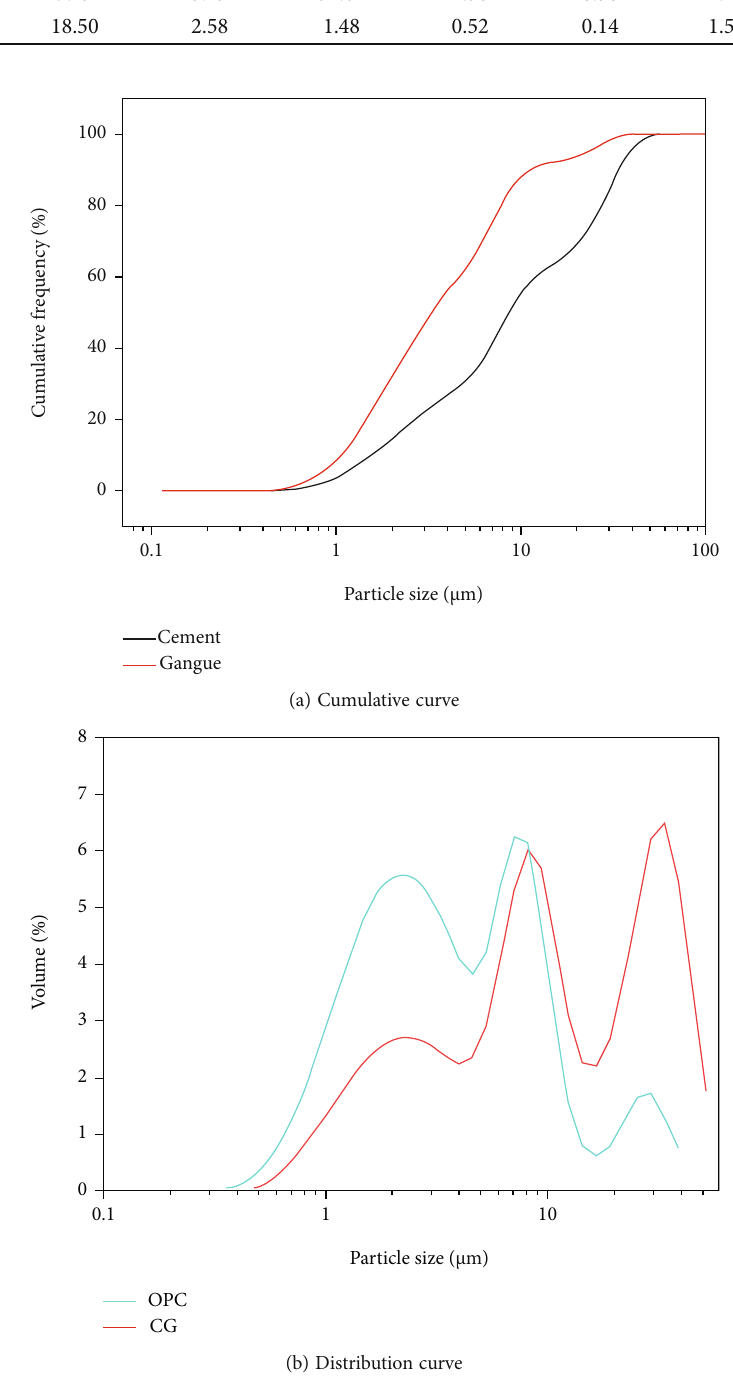
Figure 1: Particle size distribution of OPC and